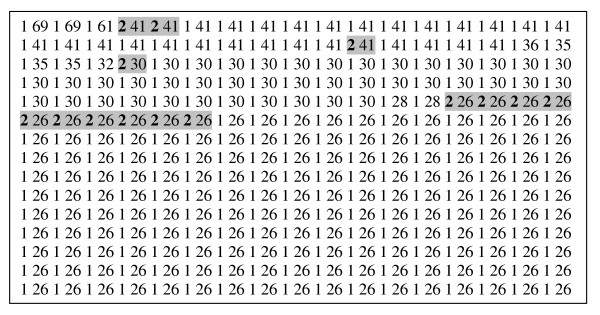
The review has 21 included studies. The MEDLINE search retrieved 1486 records. Ultraseek ranked 726 of the records as relevant and displayed the 500 with highest relevance scores. Inclusion status (1 = not included, 2 = included) is indicated, followed by the relevance score. The positions of records of included studies are highlighted.